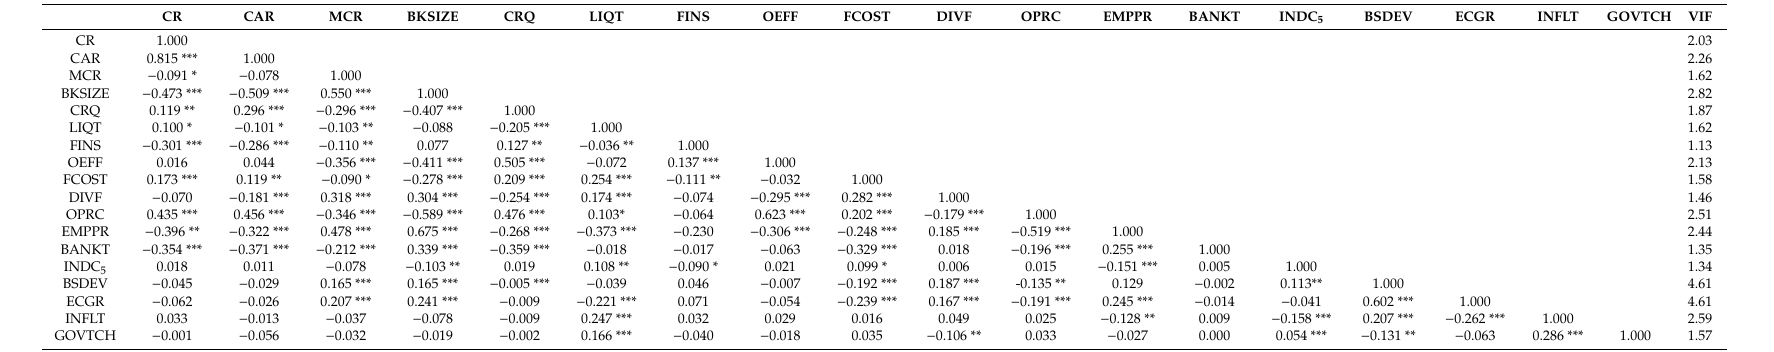
Table 6. Correlation